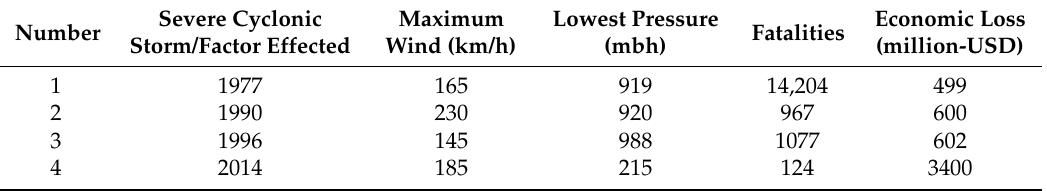
Table 4. Severe cyclonic storm and their impact since 1977 along